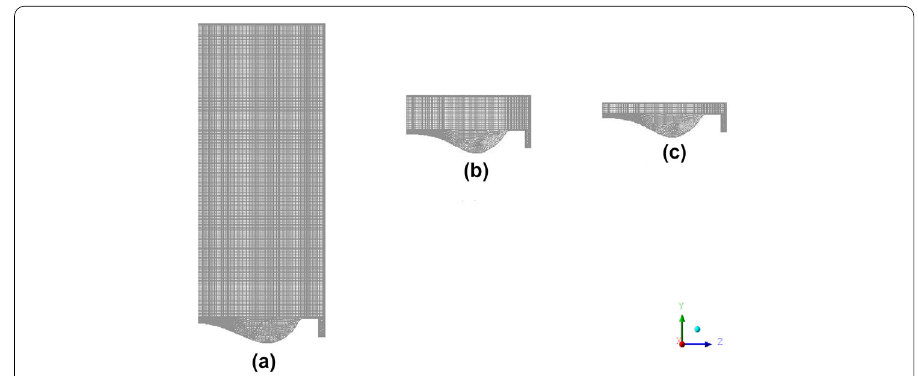
Fig. 2 Mesh on the vertical plane passing through middle of the sector at a 570 ◦ CA, b 691 ◦ CA and c 720 ◦ CA (TDC)